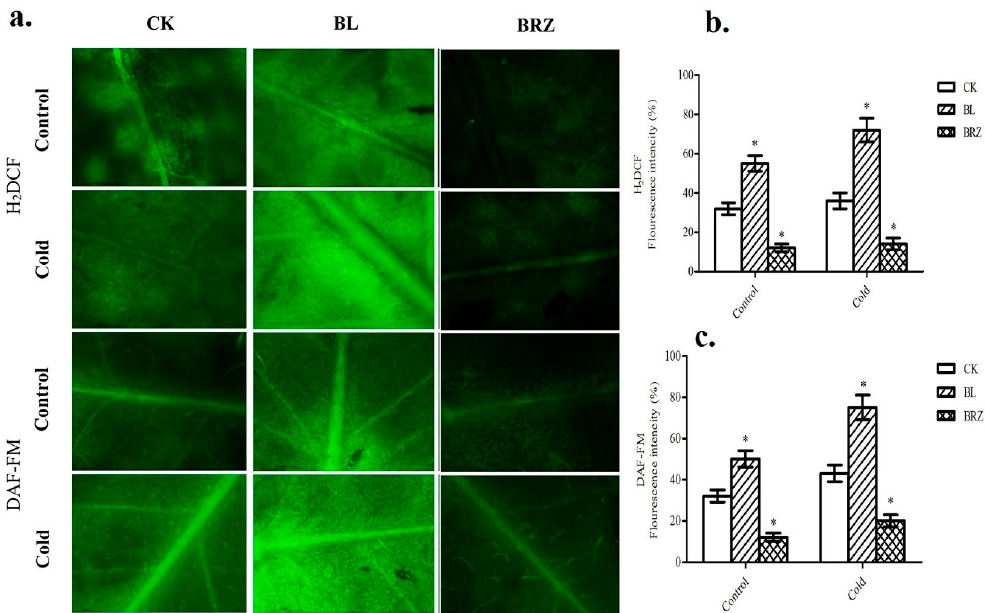
Figure 3. BRs’ role in the generation of hydrogen peroxide (H 2 O 2 ) and nitric oxide (NO). M. truncatula plants pretreated with 1 μ M BL or 1 μ M BRZ or water (CK). Images were taken after 24 h of chemical treatment using a fluorescence microscope (Scale bars = 75 μ m) ( a ). Quantitative measurements of H 2 O 2 level ( b ) and NO level ( c ) in young leaves. Bars represent mean and standard deviation of values obtained from three biological replicates. Significant differences ( p < 0.05) are denoted by asterisks. Int. J. Mol. Sci. 2019 , 20 , x FOR PEER REVIEW